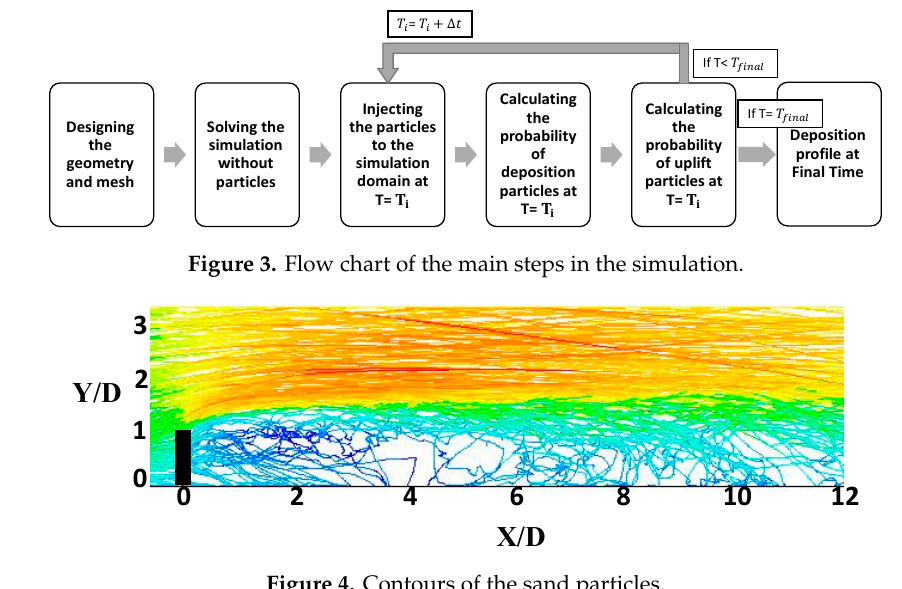
Figure 4. Contours of the sand particles.